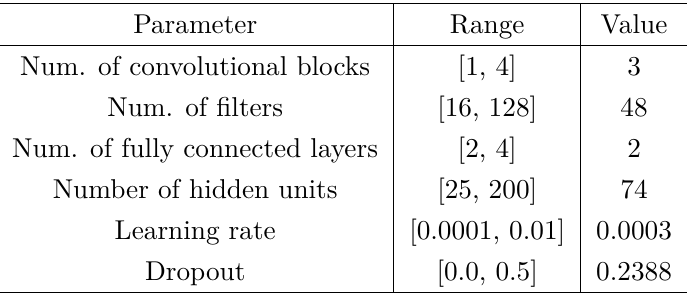
Table 2. Hyperparameter ranges for bayesian optimization of convolutional networks.